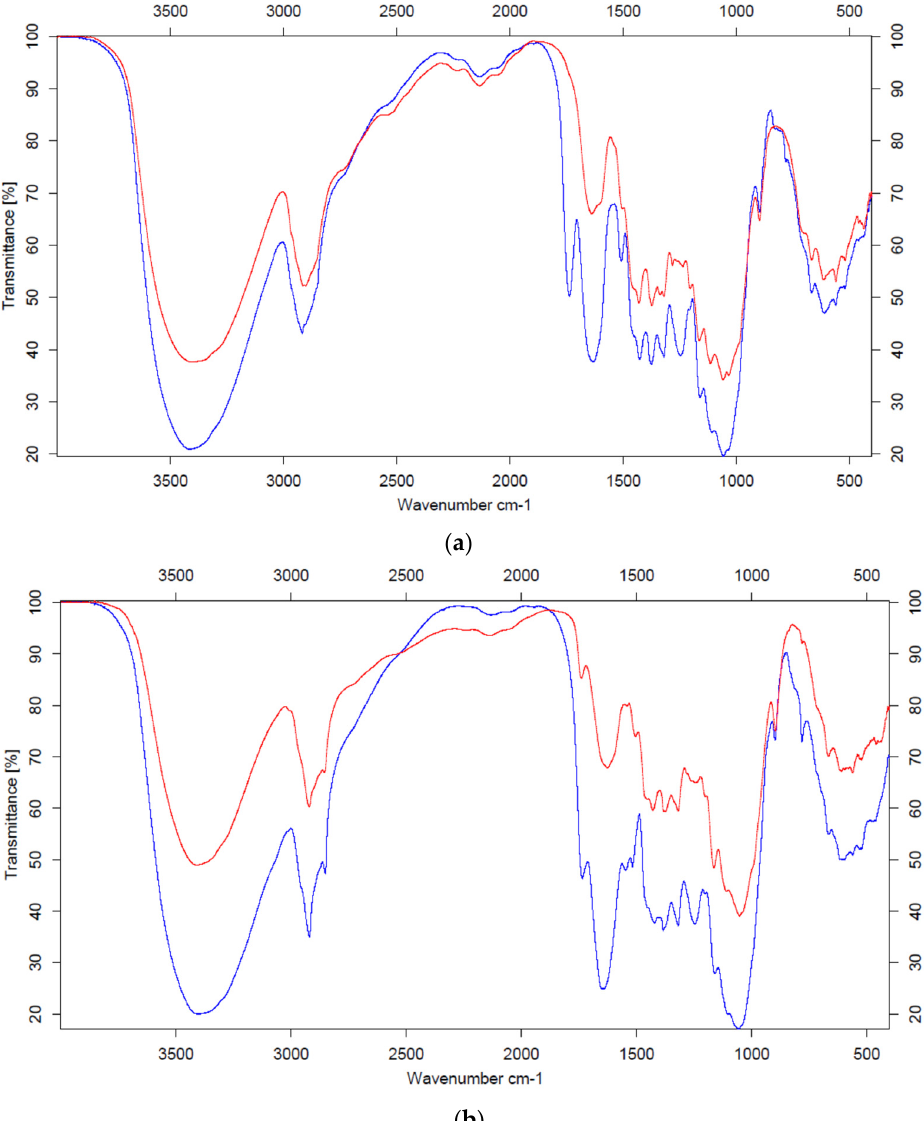
Figure 1. ( a ) FTIR spectra of hemp biomass from saline soil before (blue) and after (red) NaOH pretreatment. ( b ) FTIR spectra of grass biomass from saline soil before (blue) and after (red) NaOH pretreatment. The broad band, ranging from about 3500 to 3000 cm − 1 , comes from the O–H stretch- ing vibrations in the cellulose molecule. In all the cases, the band after pretreatment is less intense and narrower. The band at 2900 cm –1 , resulting from the stretching vibrations of the C–H group (cellulose), is also less intense after pretreatment. The decrease in the in- tensity of these bands, despite the increase in the cellulose content after treatment (con- firmed by results from the chemical composition), may be caused by the reduction in the crystalline structure of cellulose [23,24]. These bands, in the case of different materials, have a different shape (for grass, two characteristic peaks appear in this place, while for hemp, one broad band is visible). The vibration band visible at 1730 cm − 1 , resulting from the C=O stretching vibrations of the acetyl group in hemicellulose [25], disappears in the case of hemp after treatment, while in the case of grass, it is significantly reduced. This is due to the degradation of hemicellulose during the alkaline pretreatment of biomass. In turn, the lower intensity of the band at 1600 cm − 1 corresponding to the O–H stretching vibrations, reflecting the amount of water absorbed in the sample, is probably caused by the loss of water during the drying process of the samples after pretreatment [26]. The absorption band at 1510 cm − 1 , resulting from the vibrations of the aromatic ring in lignin in the case of grass, decreases after alkaline treatment, which is reflected in the chemical composition of the biomass. Significant changes are visible in the band at 1230 cm − 1 . This band is attributed to the vibration of the guaiacyl ring in lignin, as well as to the vibration of the C–O groups in pectin. After the alkaline treatment, this band disappears completely or significantly loses its intensity, which may indicate a reduction in both lignin and pec- tin. Going to the lower wavenumber values, the following three more characteristic bands for the cellulose molecule appear: 1160 cm − 1 (asymmetric C–O–C stretching vibrations), 1110 cm − 1 (C–OH skeletal vibrations) and 1050 cm − 1 (C–O–C skeletal vibrations of the py- ranose ring) [27]. These bands, despite the increase in cellulose content after chemical treatment, are reduced. This is characteristic of each biomass tested and can be attributed to the reduction in the crystalline structure of the cellulose after treatment. Significant changes on the surface of the grass and hemp biomass were observed and presented in the SEM images taken before and after pretreatment (Figure 2).